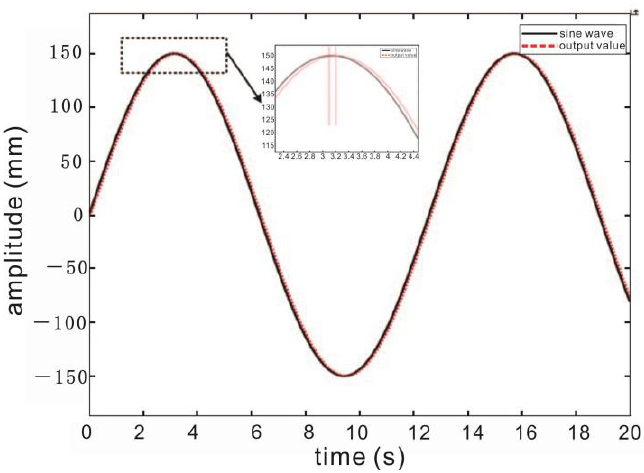
Figure 7. Sinusoidal signal simulation diagram.